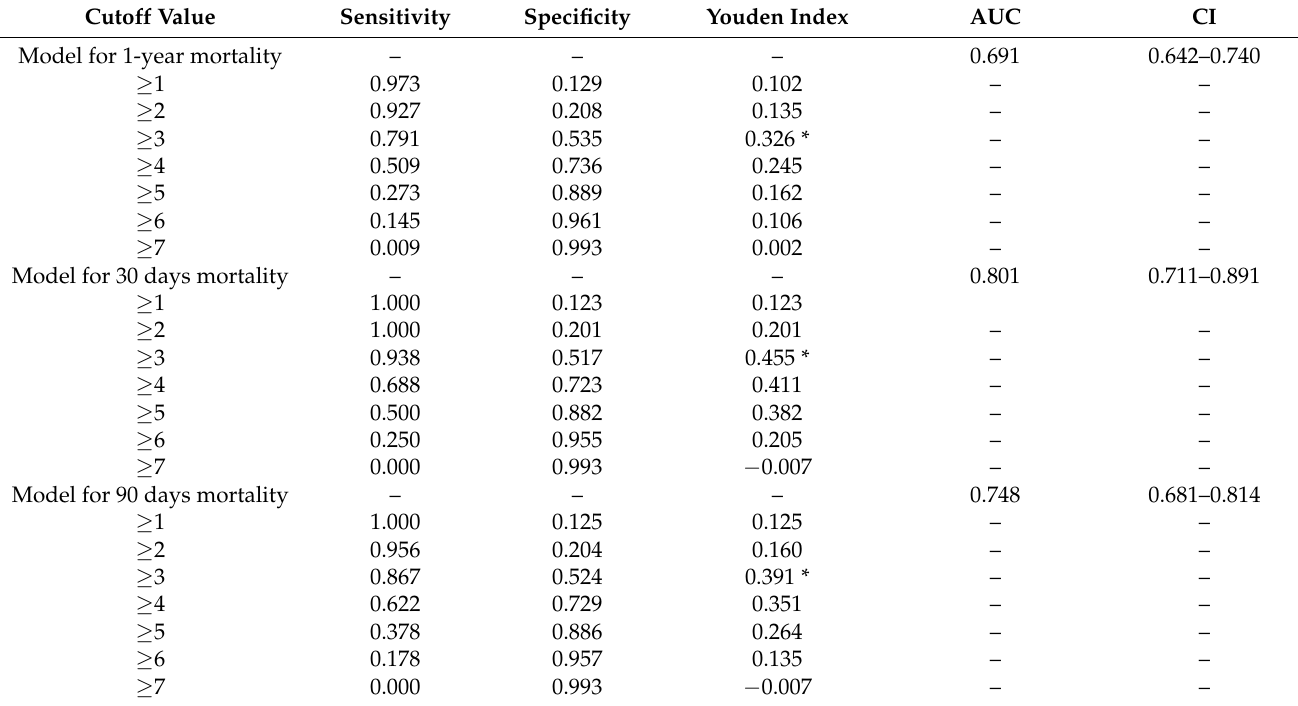
Table 3. Sensitivity, specificity, and Youden index at different cut-off points of prediction